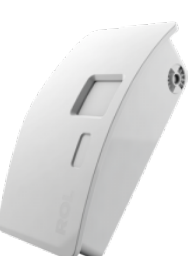
Figure 1. The low-cost and low-resolution heat sensor used in this study [24].